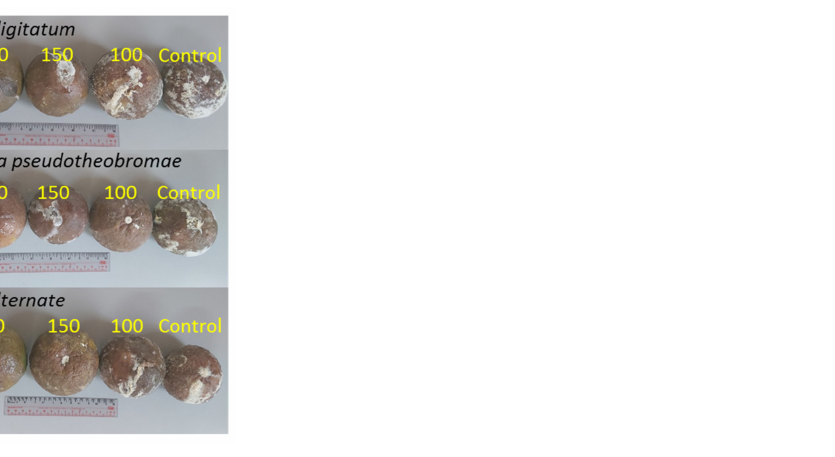
Figure 9. The antifungal activity of SCNs against three fungi on Citrus reticulata sinensis after being treated for a week.